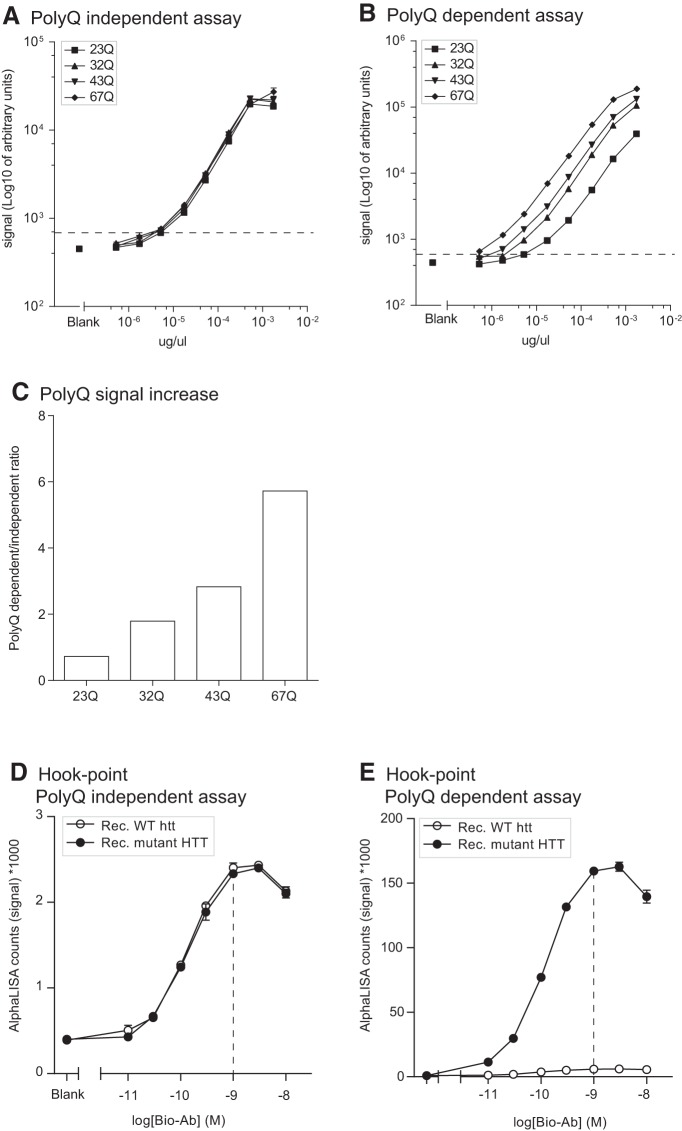
Purified HTT protein standards. Serial dilutions of full-length purified human HTT protein expressing different polyQ were used to generate standard curves with the polyQ-dependent and -independent assay (A, B). Lower limit of quantification (LLoQ) was 3 pm per well for both assays and it is indicated by a dashed line on the graphs. polyQ-dependent increase in signal intensity is displayed as the ratio of the raw AlphaLISA counts in polyQ-dependent/-independent assay at 100 pm in each well (C). Hook points were calculated using serial dilutions of the biotinylated CST5656 in the presence of constant Acceptor beads-conjugated antibody and purified HTT protein with 23 or 78Q (D, E). Best assay conditions are indicated with a dashed line at 1 nm of the biotinylated antibody. Data in A, B, D, and E are presented as mean ± SEM.